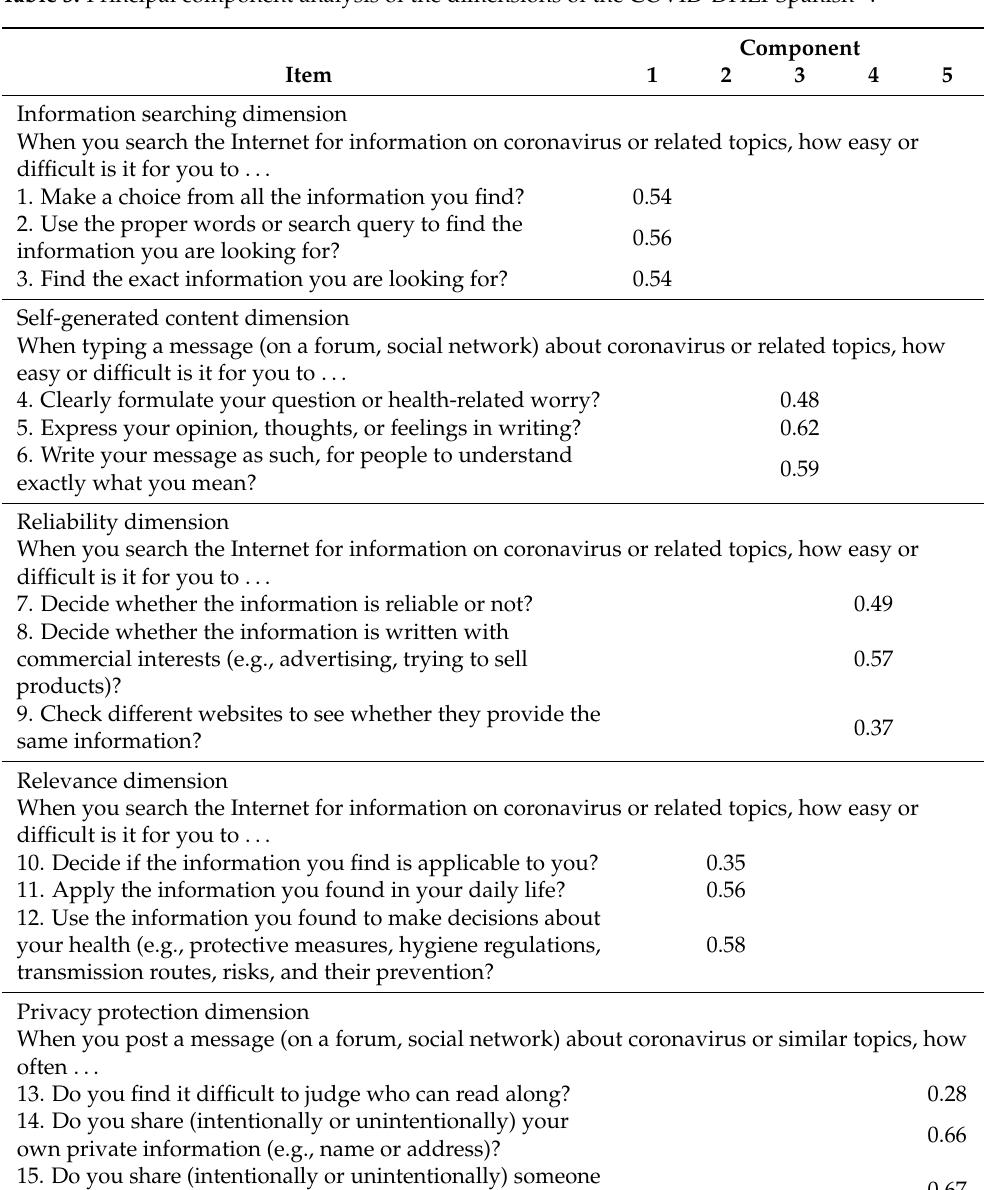
Table 3. Principal component analysis of the dimensions of the COVID-DHLI-Spanish a .